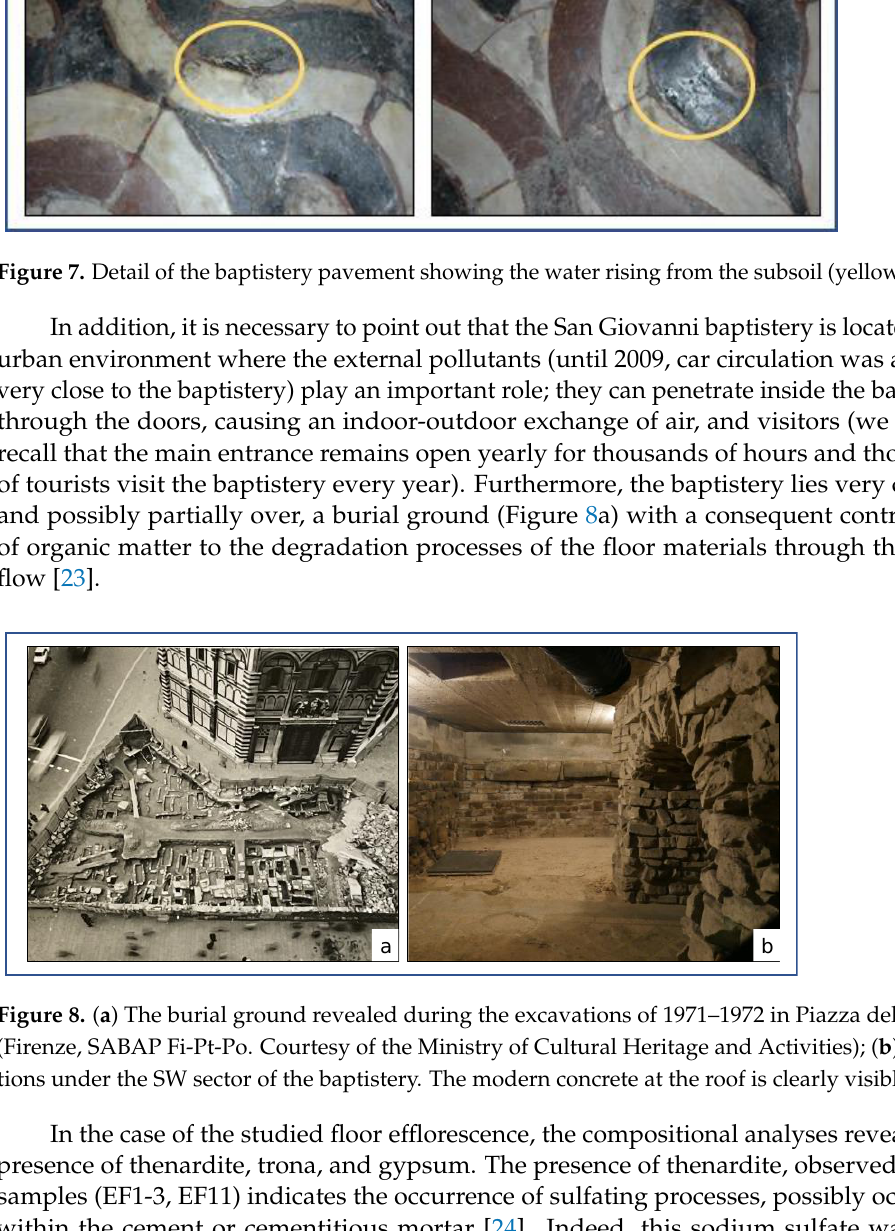
Figure 7. Detail of the baptistery pavement showing the water rising from the subsoil (yellow cir- cles).